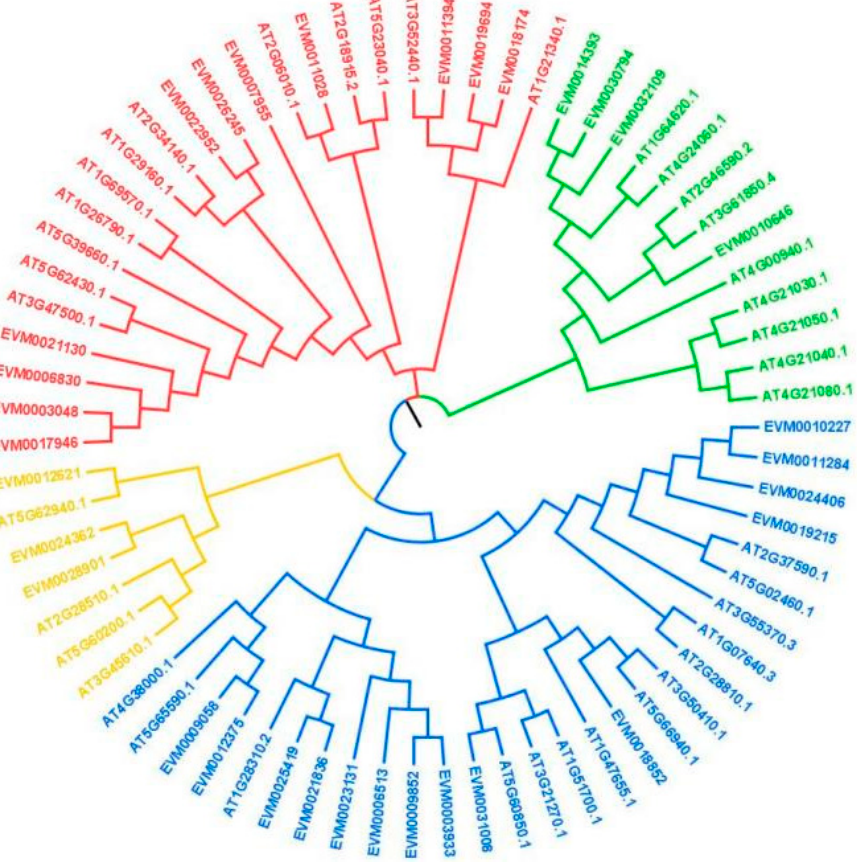
Figure 1. Phylogenetic analysis of Dof family genes from Arabidopsis and persimmon. Genes from Arabidopsis start with ‘AT’ and genes from persimmon start with ‘EVM’. All genes were clustered into four groups, highlighted in green, red, yellow and blue, respectively. 3.2. Effects of High CO 2 Treatment on ‘Gongcheng-Shuishi’ Persimmon Fruit The high CO 2 deastringency treatment was applied to ‘Gongcheng-shuishi’ persim- mon fruit. The results showed that after 1 d of high CO 2 treatment the soluble tannins content has decreased significantly compared with control and this decreasing trend contin- ued at 2 d (Figure 2). In short, high CO 2 treatment can cause persimmon fruit deastringency, and the effect is more obvious at 2